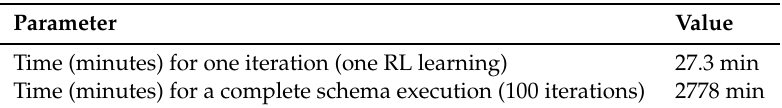
Table 4. IRL experiment mean computation time for 10 executions (in